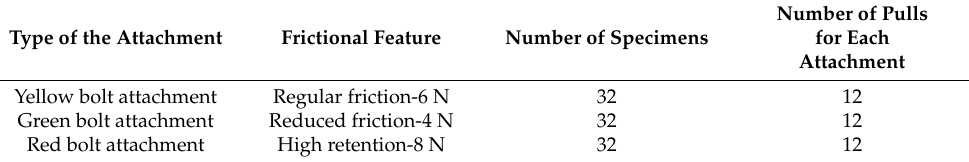
Table 1. Attachments tested.